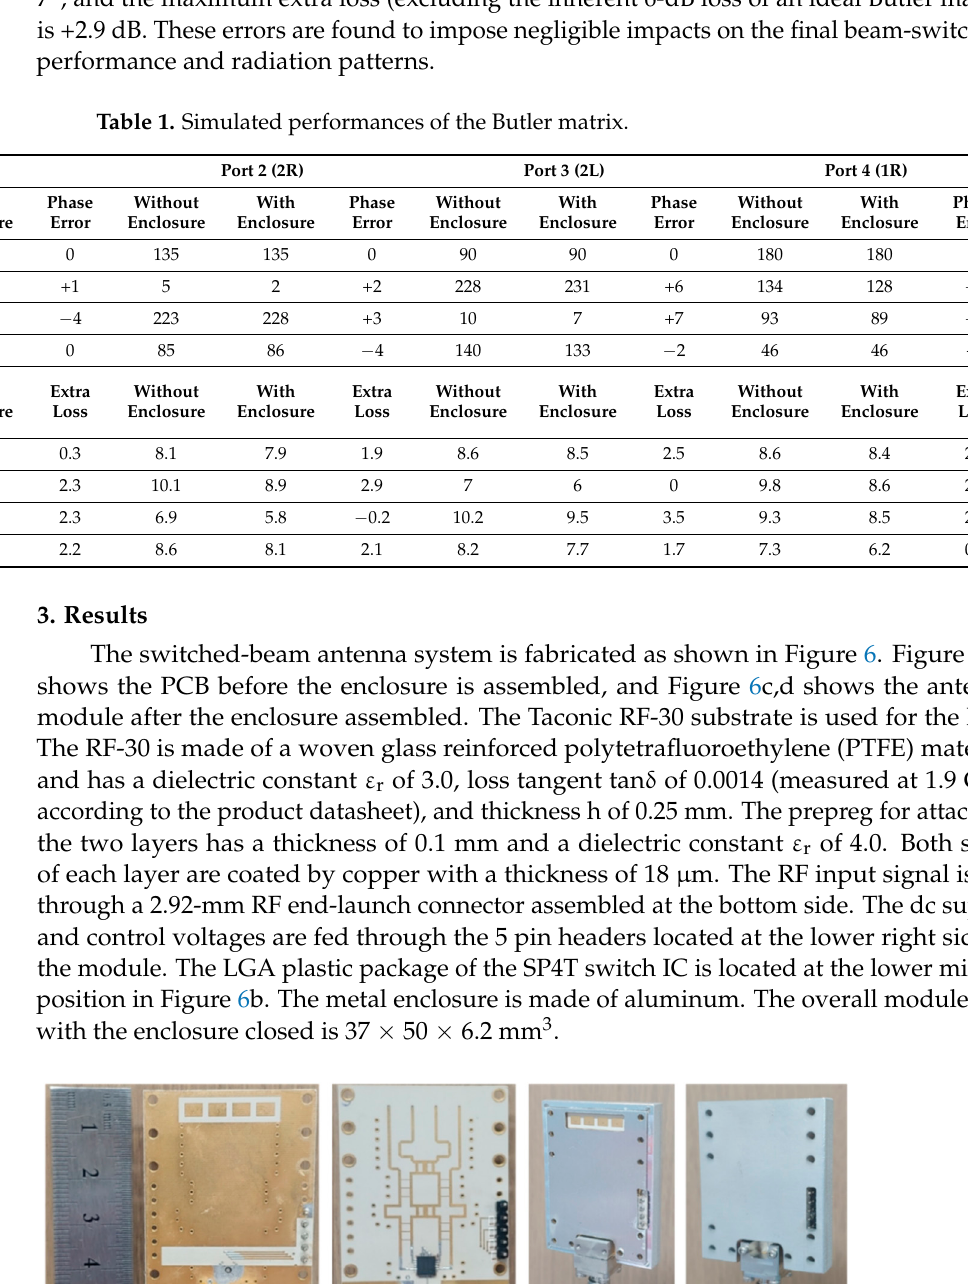
Figure 7. Measured S 11 . 22